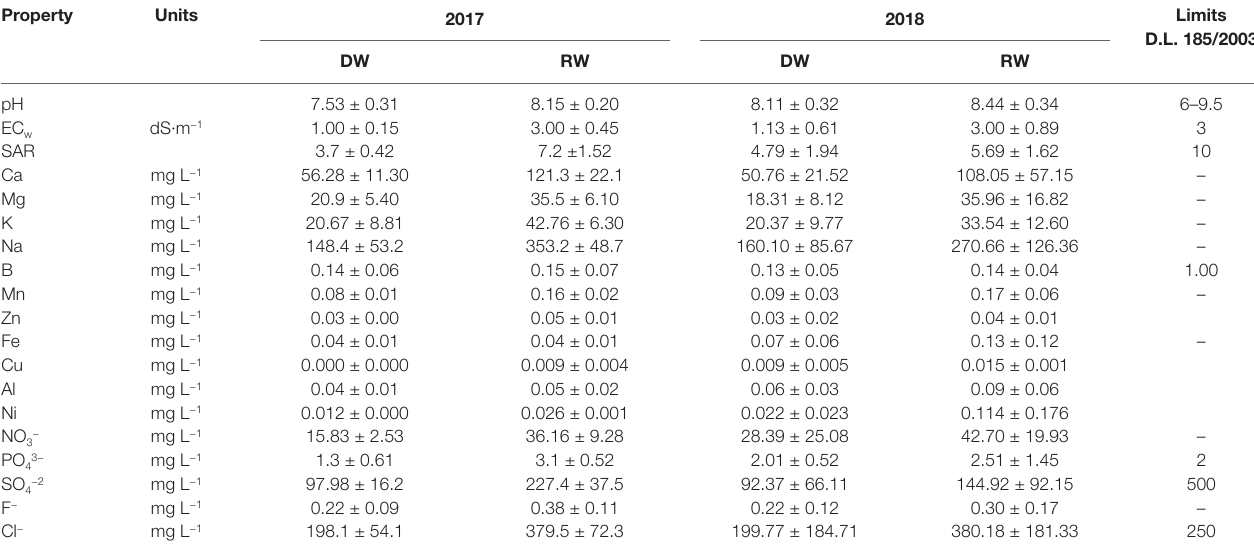
TABLE 1 | Physical and chemical properties for DESERT desalinated water (DW) and reclaimed water (RW) in 2017 and 2018. Property